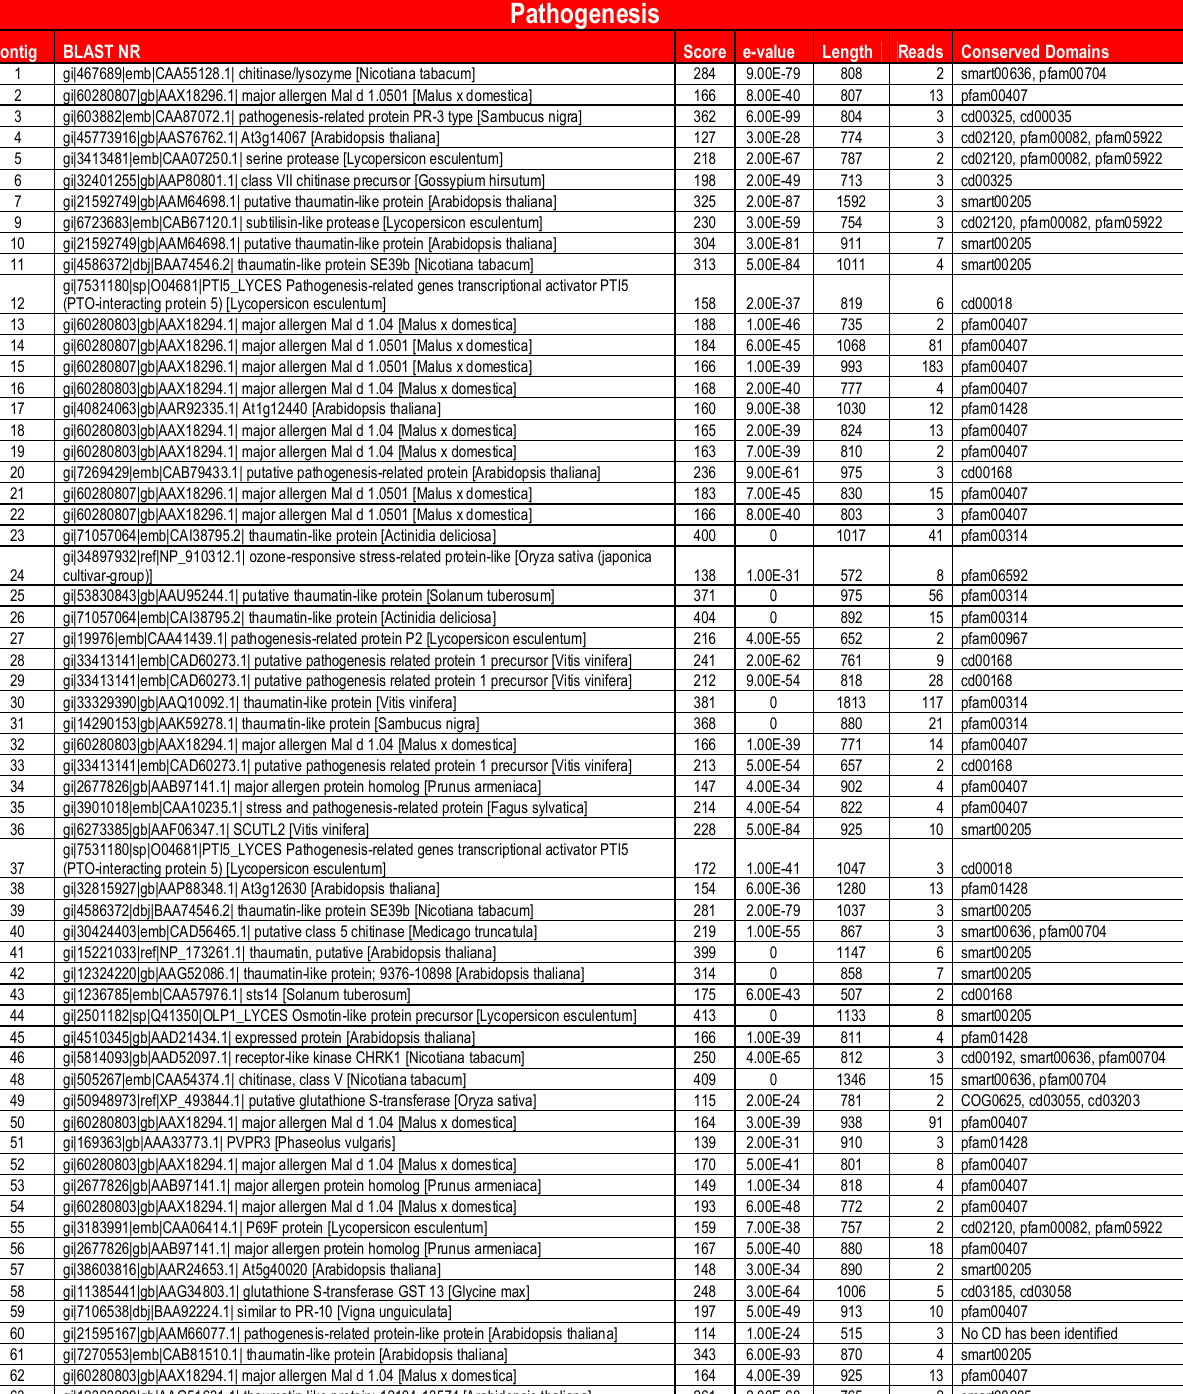
Table S4 : EST-Contigs with e-value < e -20 and score > 100 obtained in the Project Pathogenesis, and their blast hit, score, e-value, size, number of reads, and conserved domains from putative proteins